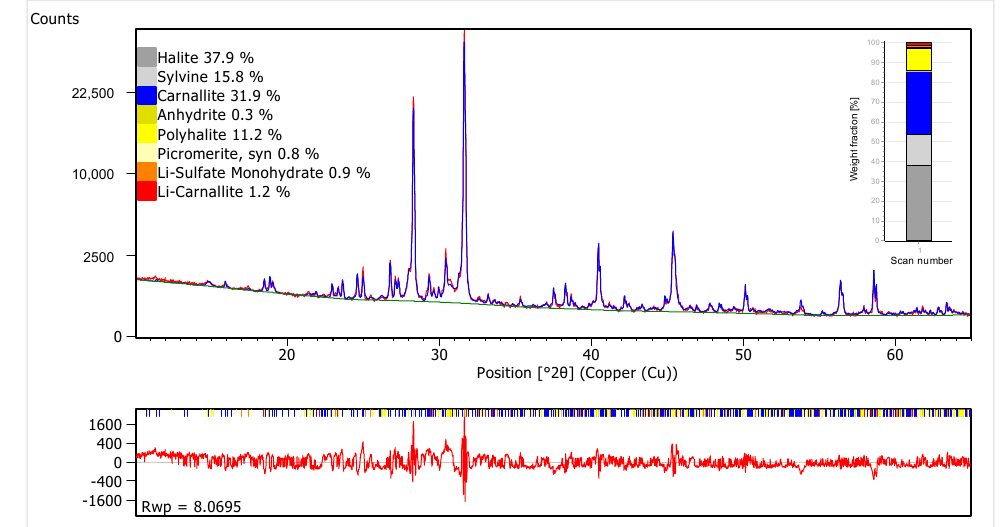
Figure 44. Example of a full-pattern Rietveld quantification of a lithium ore from a brine.